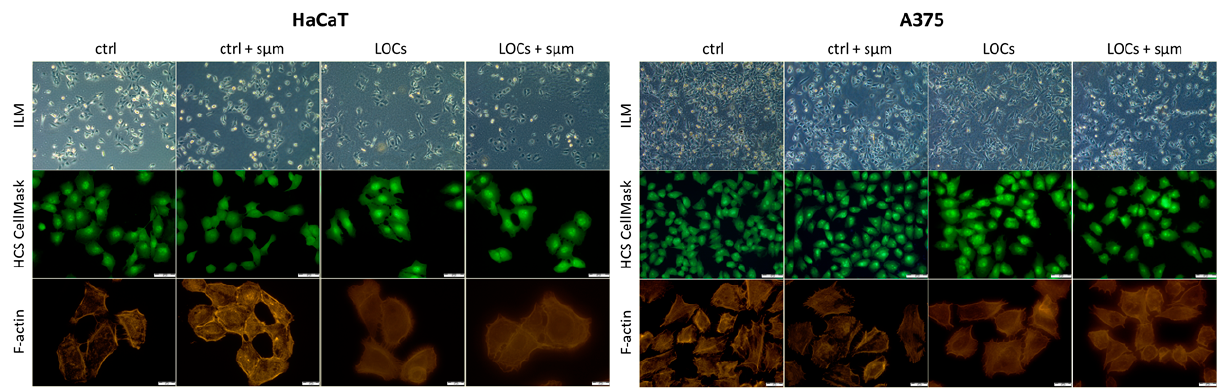
Figure 5. The representative photographs of the morphology of HaCaT and A375 cells exposed to simulated microgravity (ILM); scale bars: 50 µ m for HCS CellMask and 20 µ m for F-actin.